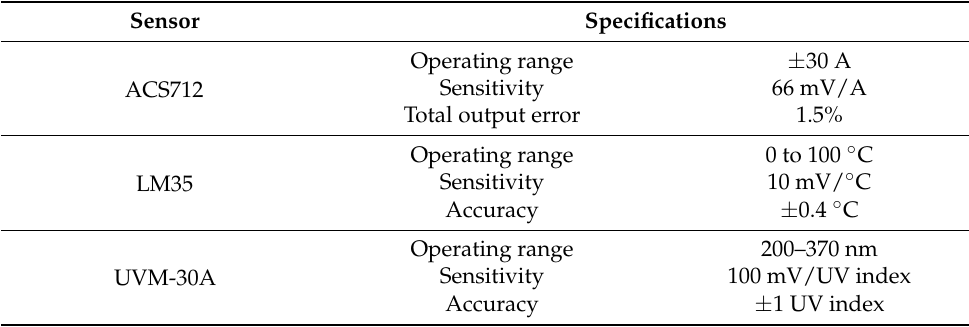
Figure 4. PV installation under test. Table 3. Technical specifications of the sensors for the experimentation.